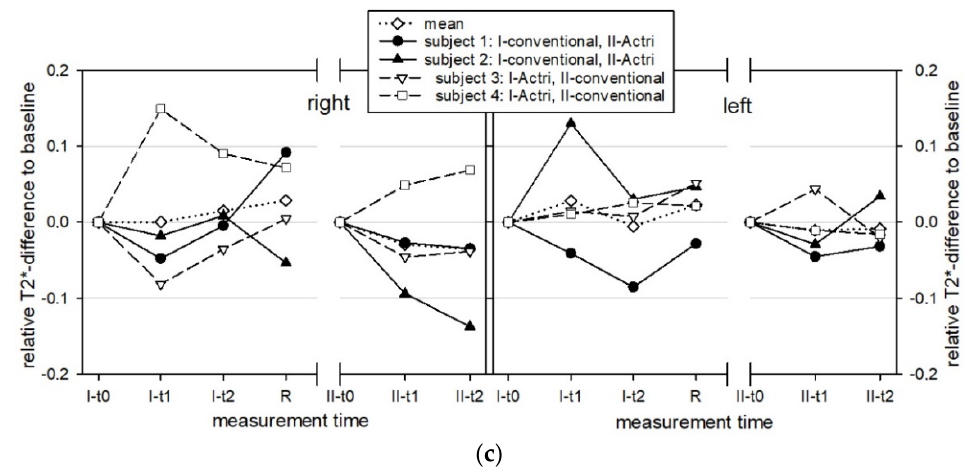
Figure 4. ( a ) Relative Changes of Mean Cartilage T2* in the Medial FTJ. ( b ) Relative Changes of Mean Cartilage T2* in the Lateral FTJ. ( c ) Relative Changes of Mean Cartilage T2* in the retropatellar. At the recovery measurement, the T2* time in all four subjects was elevated in almost all FTJ segments but not in the retropatellar (Figure 4).